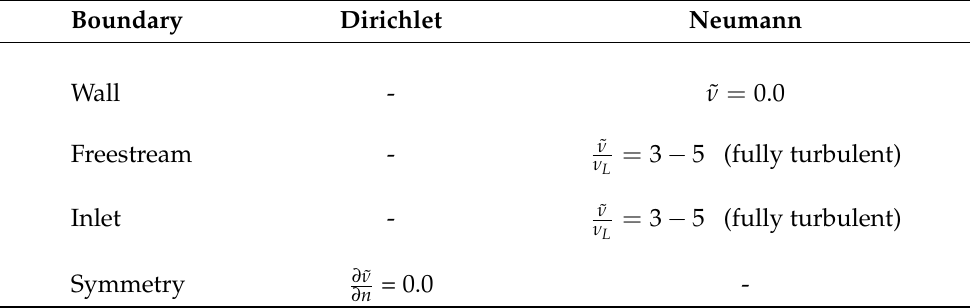
Table 2. Spalart–Allmaras boundary